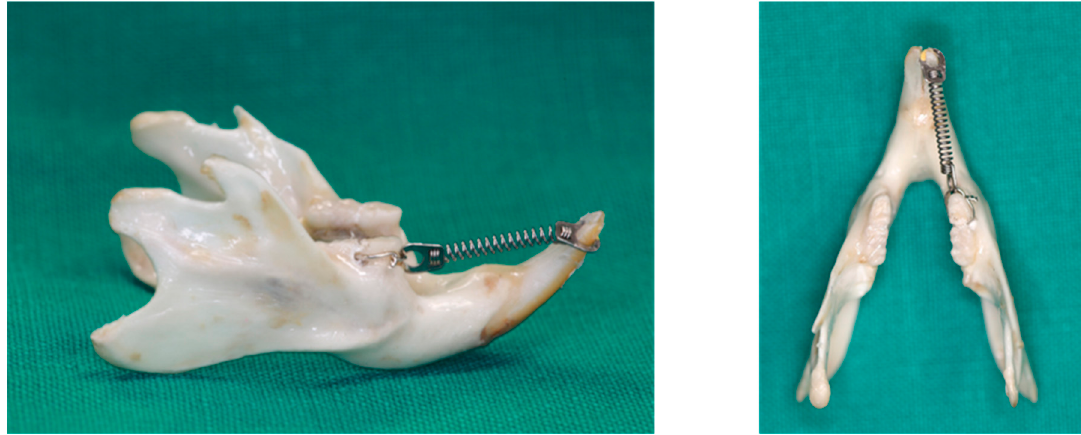
Figure 9. Application of an orthodontic appliance in a rat model.